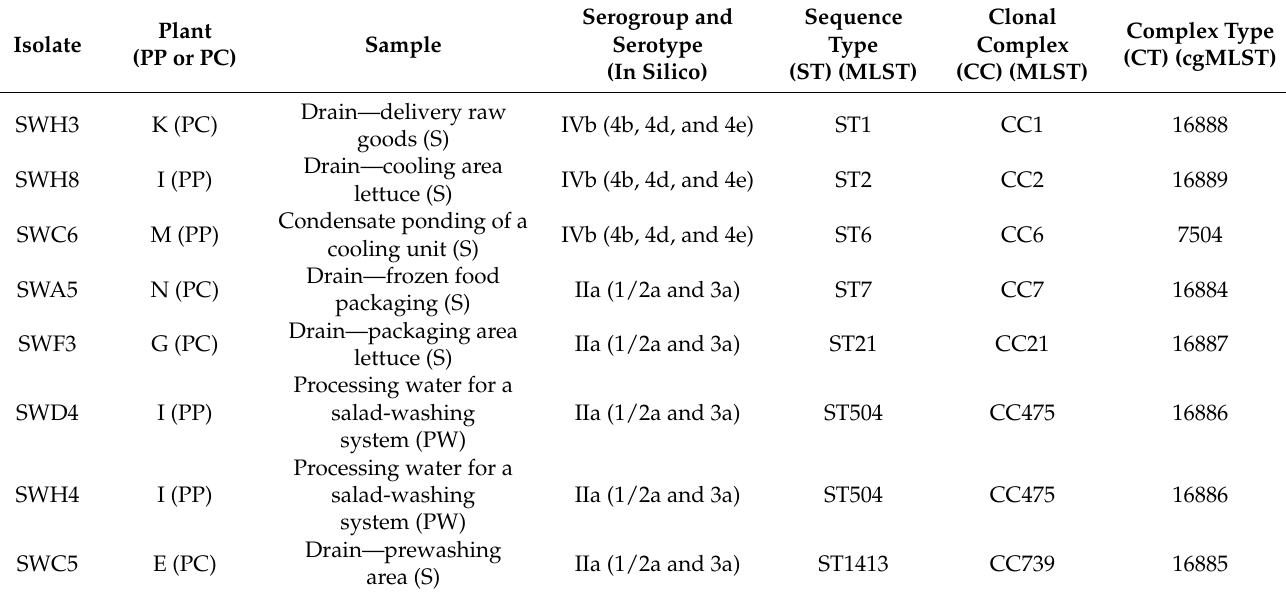
Table 1. Characterization of the L. monocytogenes isolates from FNAO